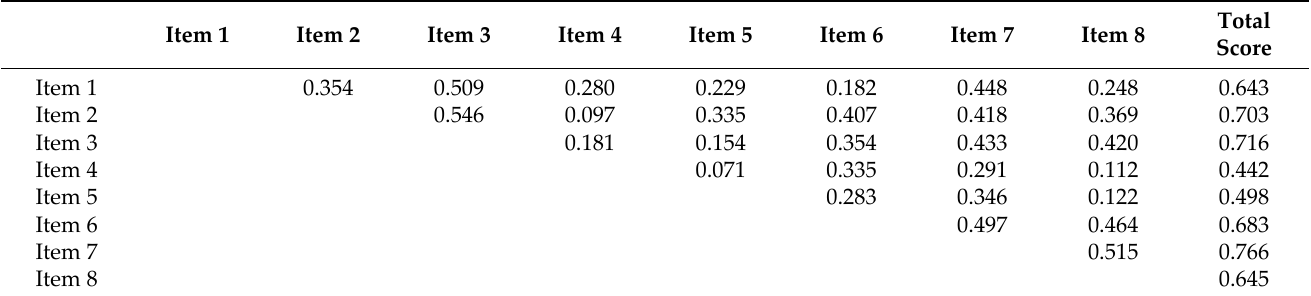
Table 4. The inter‑item relevance matrix of